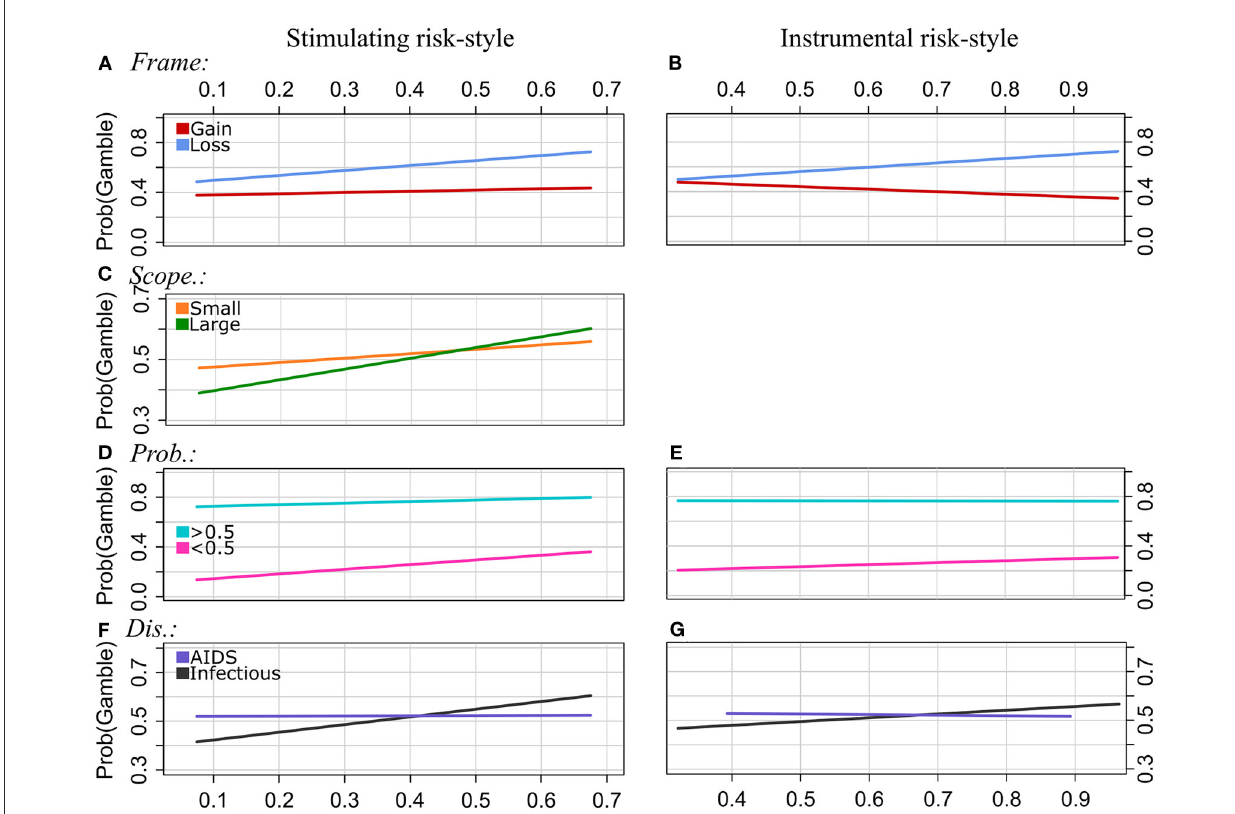
FIGURE3 Experiment 1: Regression lines of the proportions of choosing the gamble option as a function of stimulating risk-style (left column) and instrumental risk-style (right column), separately for the levels of Frame [pattern (A, B) ], Scope [ (C) , effect of EX by Scope was n.s.], Probabilities (D, E) , and Disease (F, G) . Note that we applied a smaller range of values on the y-axis for the plots of the patterns (C, F, G) to illustrate the interaction effect more